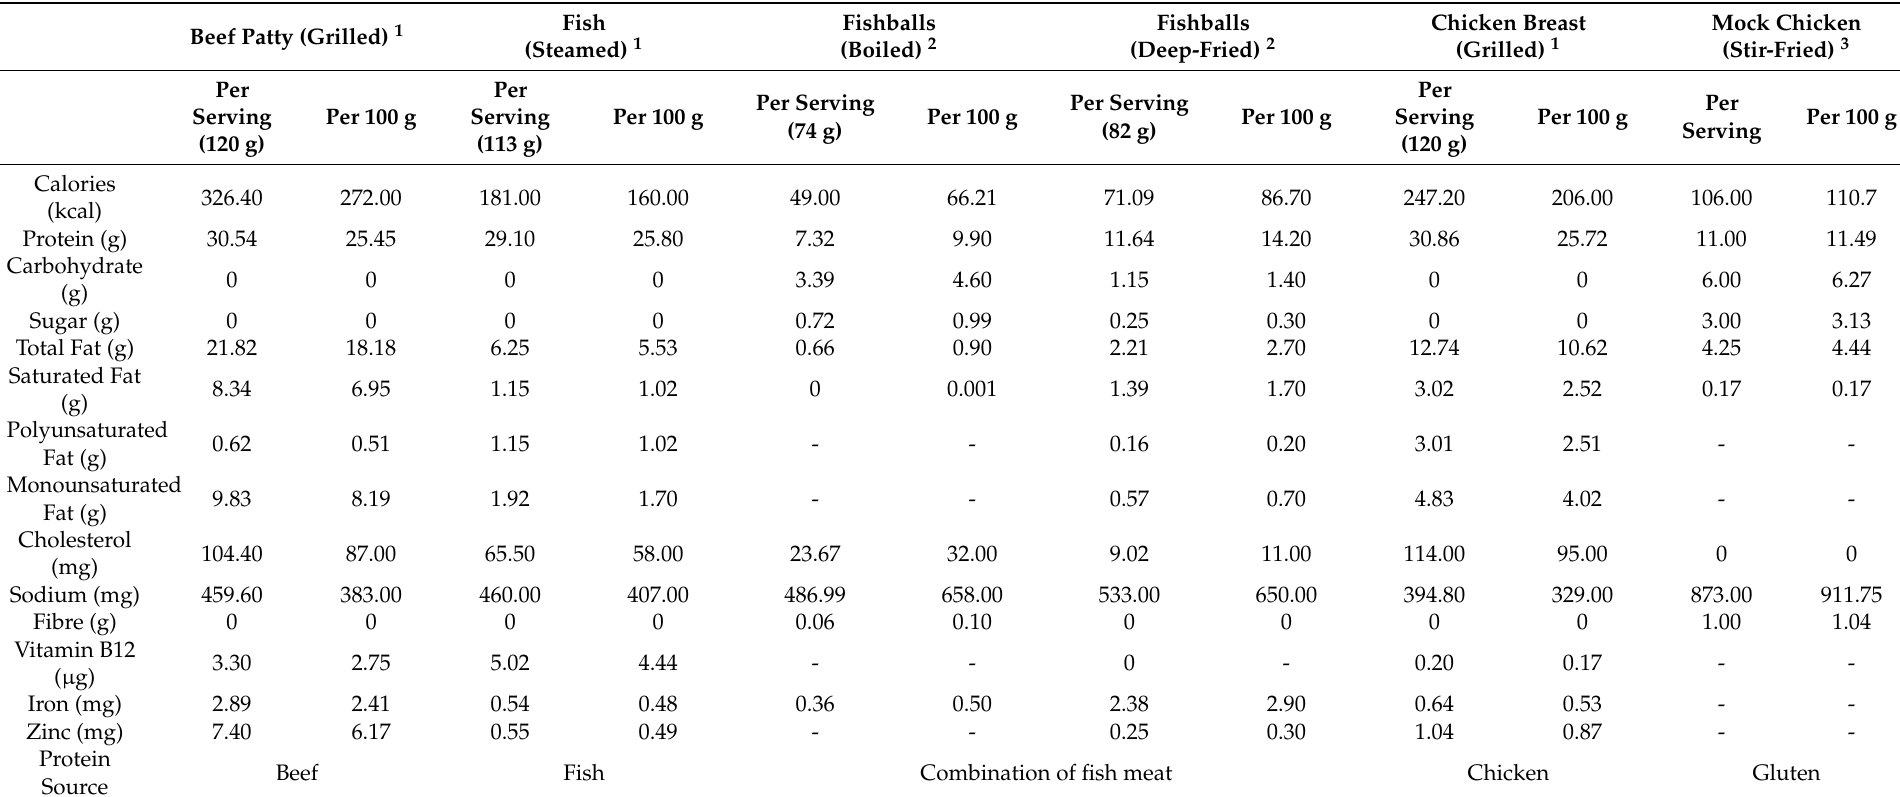
Table 3. Comparison of conventional meat, processed fish sources and alternative protein (mock chicken), as prepared and ready-to-eat.